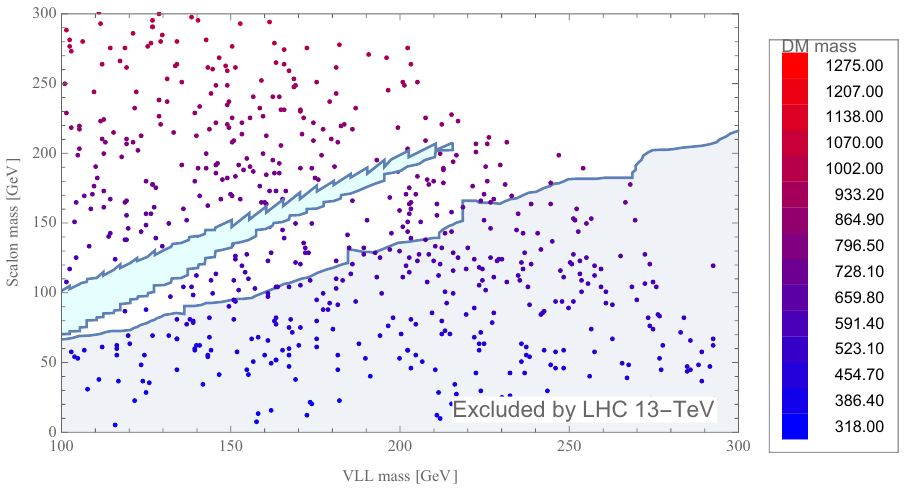
Figure 2 . The plot shows the VLL mass against the scalon mass with the DM mass in the color axis. The light blue region is excluded by the 13-TeV LHC and the region shaded cyan is excluded by the soft lepton